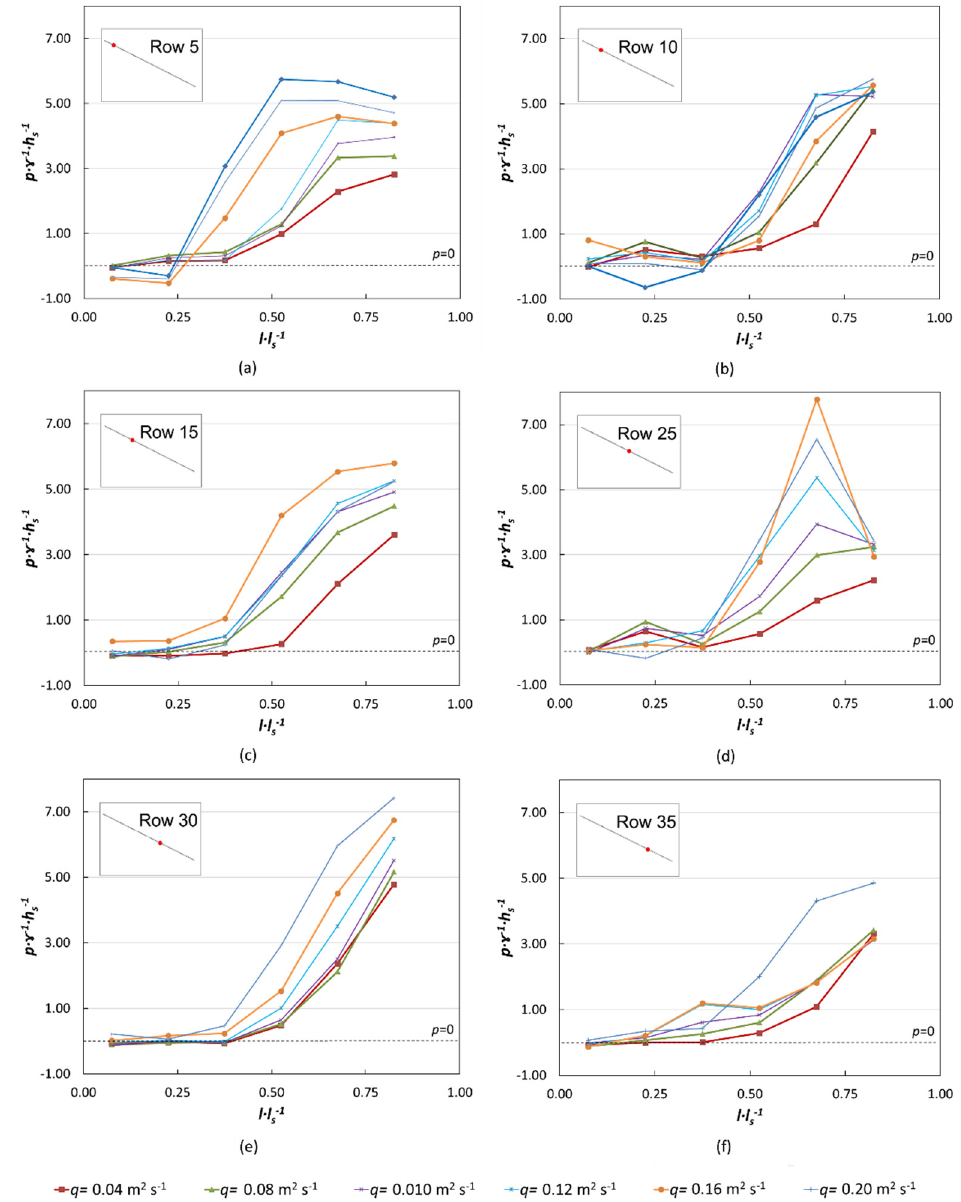
Figure 11. Mean pressures on the tread of the Armorwedge™ block ( w 1) in free draining conditions ( d 1). ( a ) Row 5; ( b ) row 10; ( c ) row 15; ( d ) row 25; ( e ) row 30; ( f ) row 35.